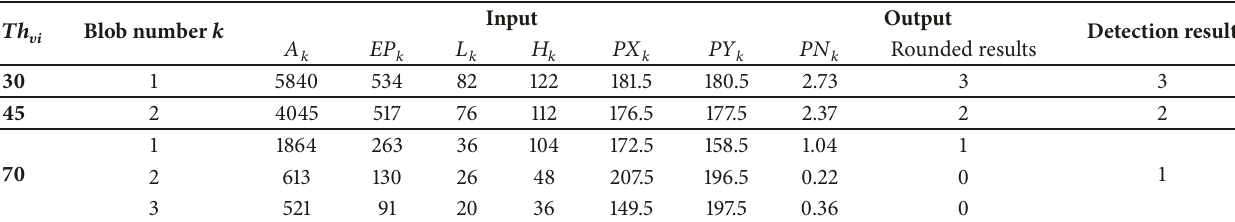
Table 4: The results of pedestrian counting with different threshold 𝑇ℎ V 𝑖